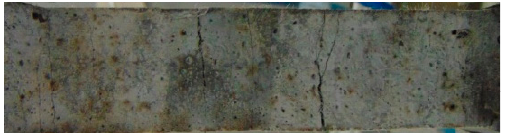
Figure 11. Multiple cracking pattern of tensile specimen for HDC.